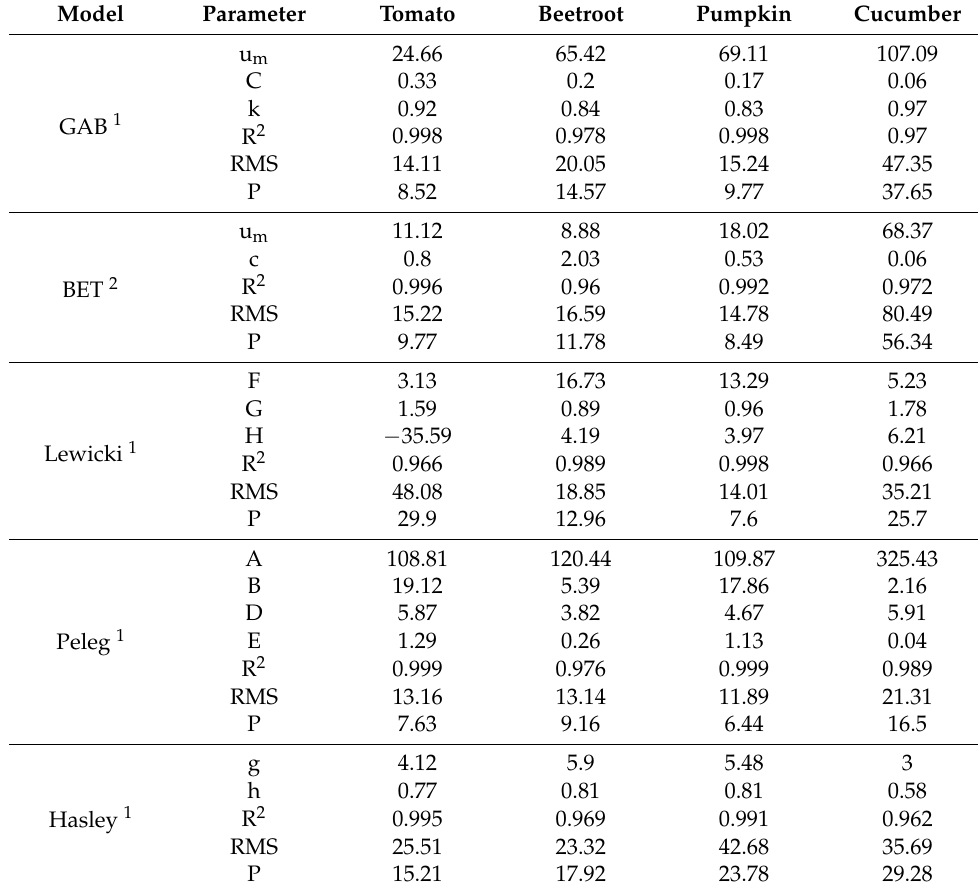
Table 8. Parameters of isotherm sorption models obtained for different freeze-dried soups. Model